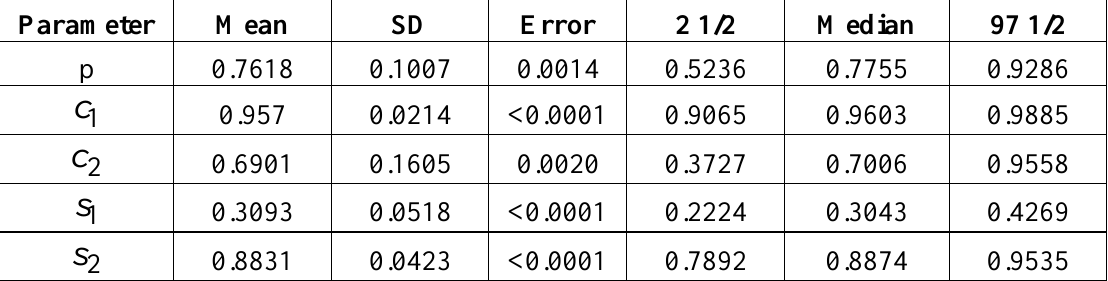
Table 23. Posterior analysis for the stool and serology